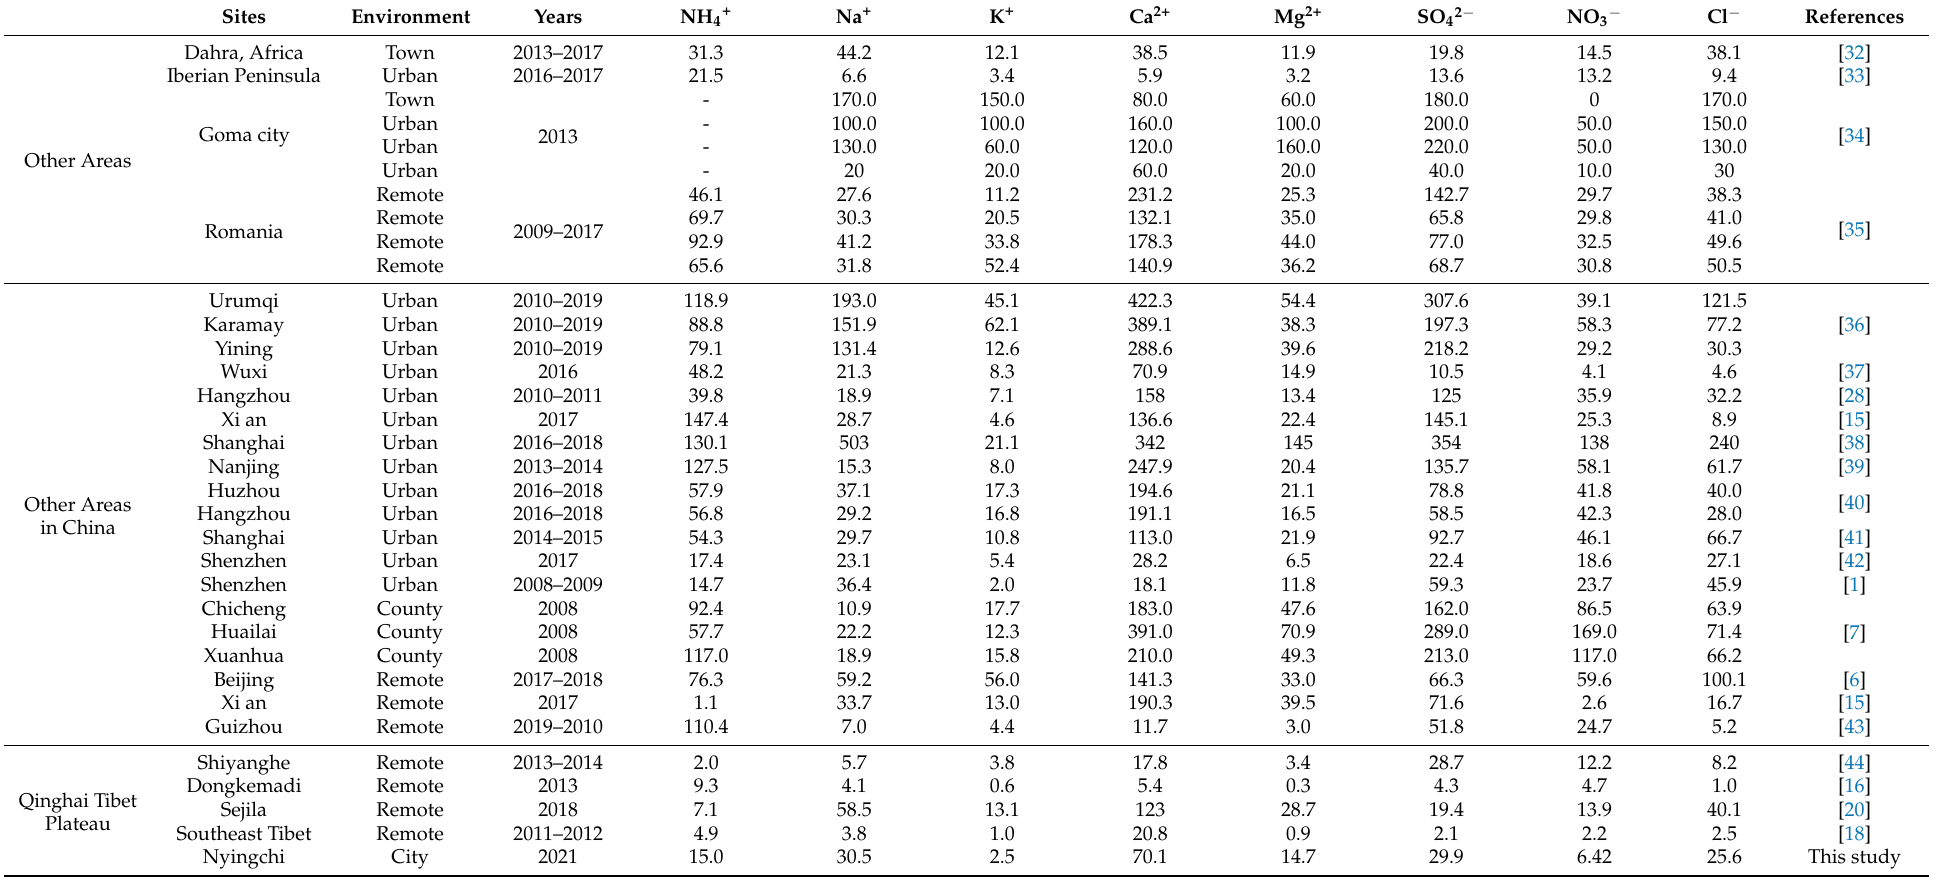
Table 3. Comparison of major ion concentrations (in µ eq L − 1 ) at sampling sites with other